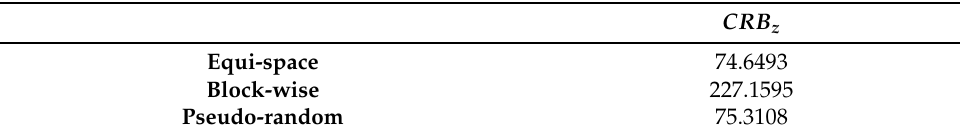
Table 1. CRLB z for various subcarrier allocation